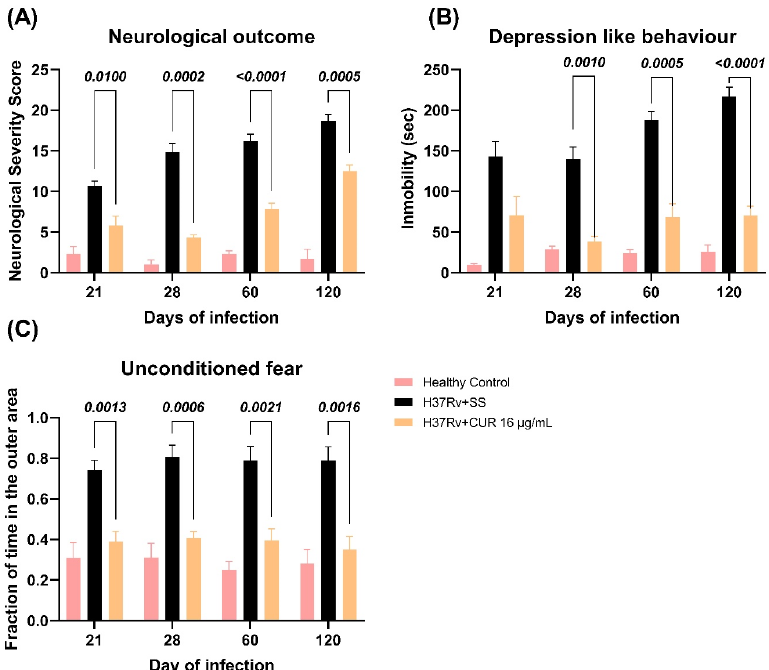
Figure 7. Effect of curcumin (CUR) treatment (16 μ g/mL) on neurological damage, depression-like behavior and unconditioned fear of TB mice. ( A ) Neurological outcome of mice treated with CUR, control mice that only received saline solution (SS) as the vehicle, and healthy mice without infection. F (2, 12) = 142.2, p < 0.0001. Two-way ANOVA. p < 0.0001. Dunnett’s multiple comparisons test. ( B ) Depression-like behavior of mice treated with CUR, control mice that only received SS as the vehicle, and healthy mice without infection. F (2, 12) = 154.6, p < 0.0001. Two-way ANOVA. Dunnett’s multiple comparisons test. ( C ) Unconditioned fear of mice treated with CUR, control mice that only received SS as the vehicle, and healthy mice without infection. F (2, 15) = 45.82, p < 0.0001. Two-way ANOVA. Dunnett’s multiple comparisons test. Data are presented as mean ± SEM ( n = 6/day/group). The treatment with CUR decreased neurological damage from day 21 post-infection and decreased the depression-like behavior of infected animals from day 28. The treatment decreased the unconditioned fear from day 21.